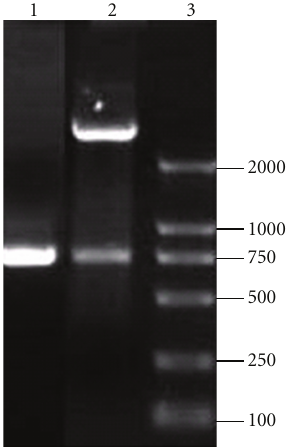
Figure 1: Restriction enzyme and PCR analysis of pNZ8112- VP4. Lane 1, a 756 bp VP4 fragment amplified from recombinant plasmid DNA pET-VP4; Lane 2, Sph I and Xba I digestion of the recombinant expression vector pNZ8112-VP4 showing both vector and insert; Lane 3, 2000 bp DNA